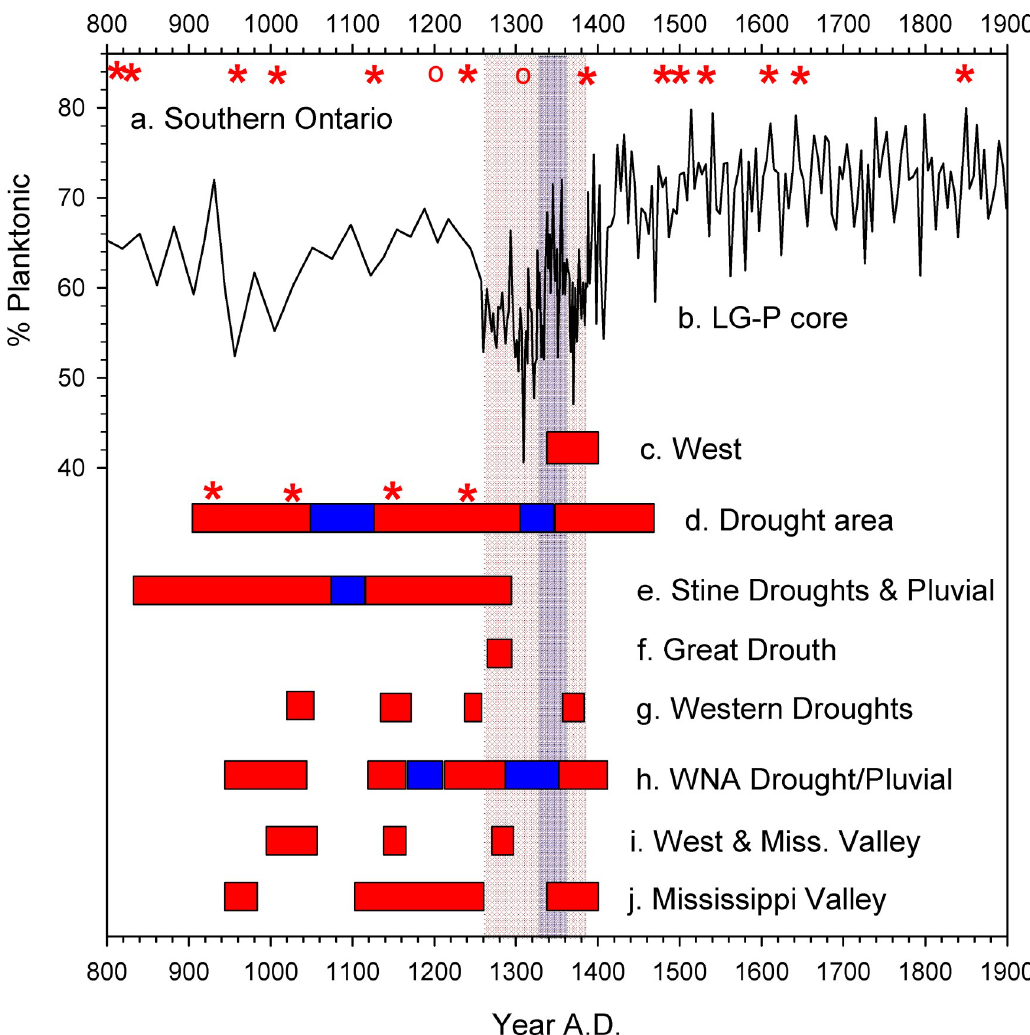
Fig 6. Hydroclimate variability at Little Green Pond in comparison to tree ring-based hydroclimate reconstructions from western North America and the Mississippi Valley. Vertical bars indicate drought (tan) and wet (violet) intervals in the LG-P record. Horizontal bars indicate extreme droughts (red) and wet periods (blue). (a) Dry decades registered in tree ring records from southern Ontario [9]. Asterisks (circles) represent severe (moderate) drought. (b) Percent planktonic diatoms in core LG-P. (c) Megadrought in the West [44]. (d) Periods of extensive droughts and pluvials in the Southwest [38]. Asterisks indicate maximum extent of droughts. (e) "Stine Droughts" and intervening wet period [40]. (f) "Great Drouth" linked to Anasazi Pueblo collapse [38]. (g) Droughts in western North America [34]. (h) Western North American droughts and wet periods [43]. (i) Droughts in the West and Mississippi Valley [44]. (j) Droughts in the Mississippi Valley associated with major cultural disruptions